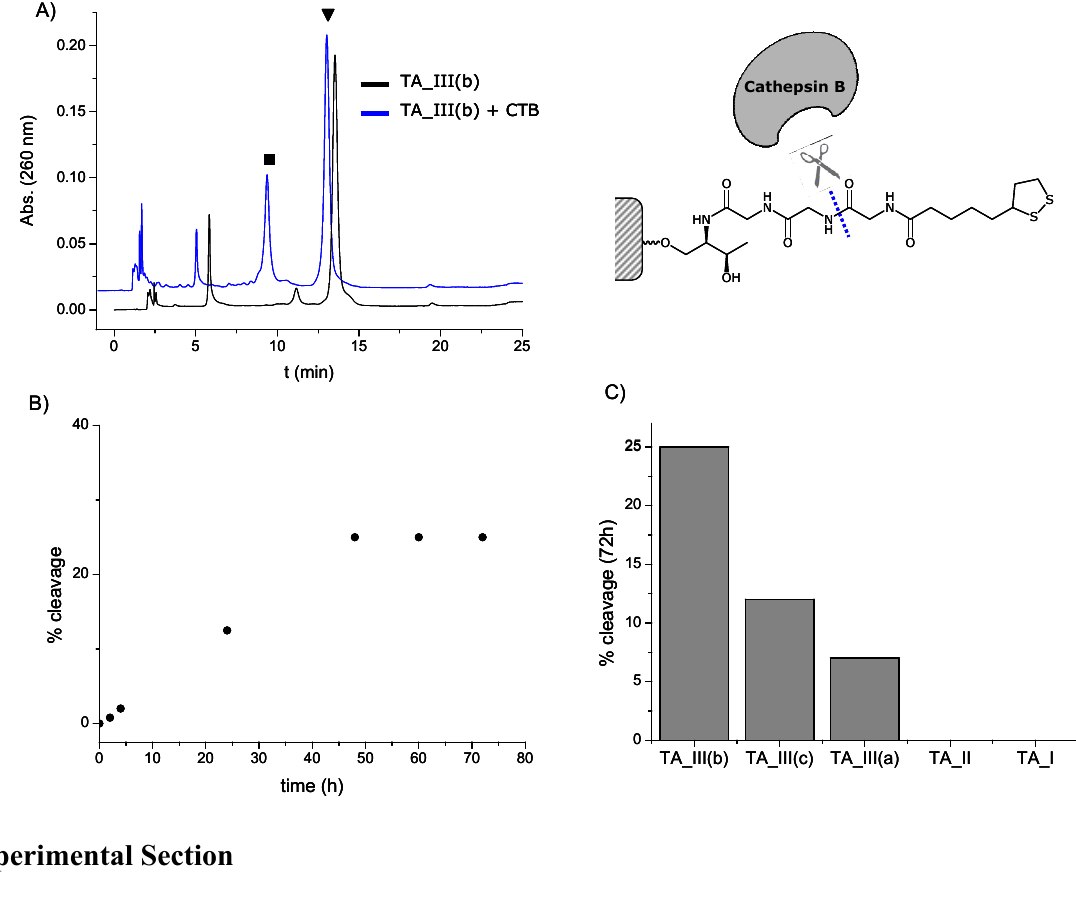
Figure 5. ( A ) HPLC profiles obtained with TA_III(b) after 72 h in the presence (blue line) and in the absence (black line) of cathepsin B (CTB). ▼ stands for TA_III(b) and ■ stands for the product resulting from the amide-bond cleavage; ( B ) % amide-bond cleavage of TA_III(b) with time; ( C ) % amide-bond cleavage after 72 h of different TA-terminated